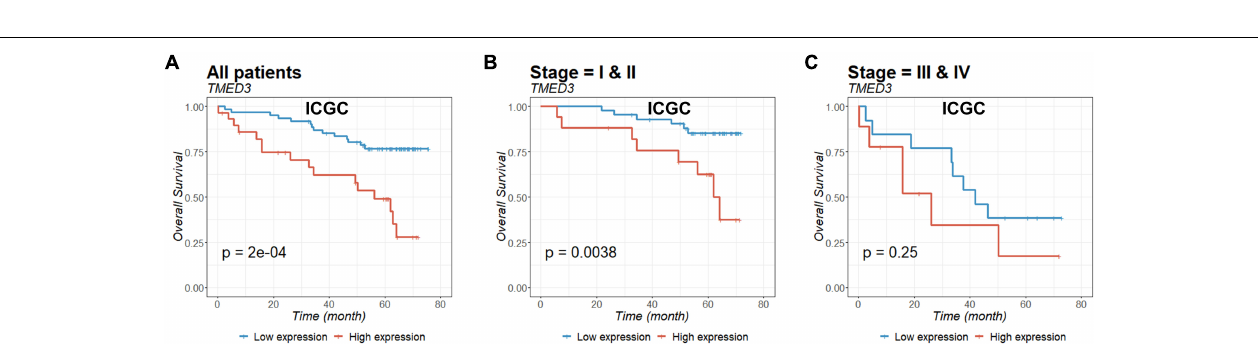
FIGURE 3 | Overall survival of all (A) , stage I and II (B) , and stage III and IV (C) patients in the ICGC cohort were examined according to TMED3 gene expression levels. P -values were calculated by the log-rank test and are shown at the bottom left of each